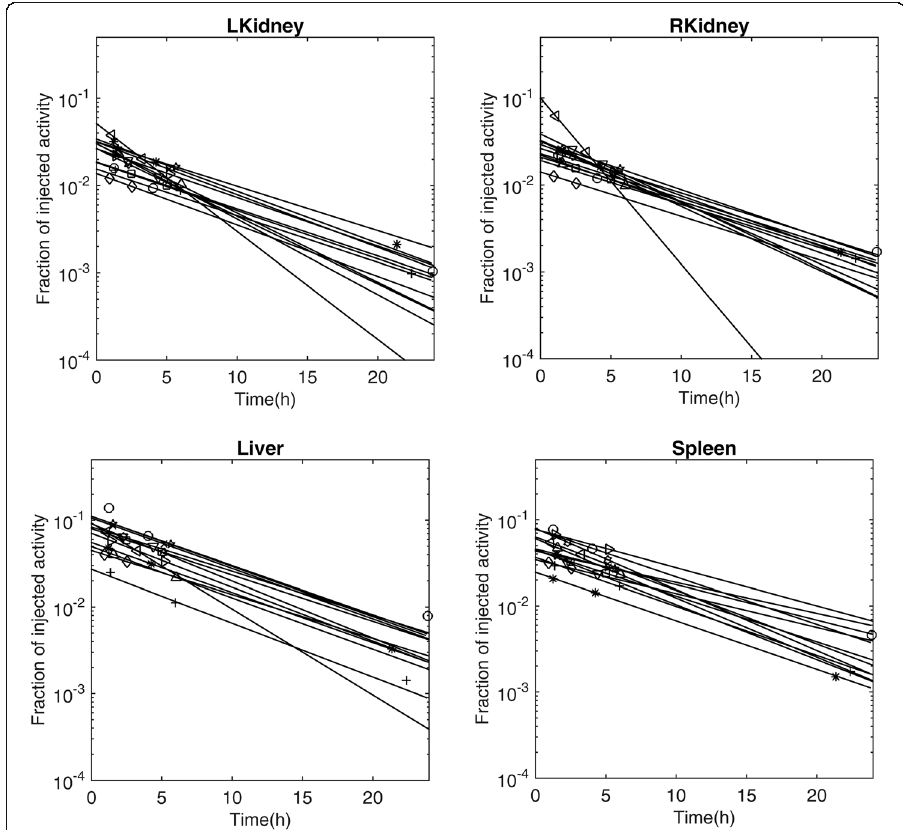
Fig. 3 Organ time-activity curves based on mono-exponential fittings for all of the patients. Different symbols correspond to different